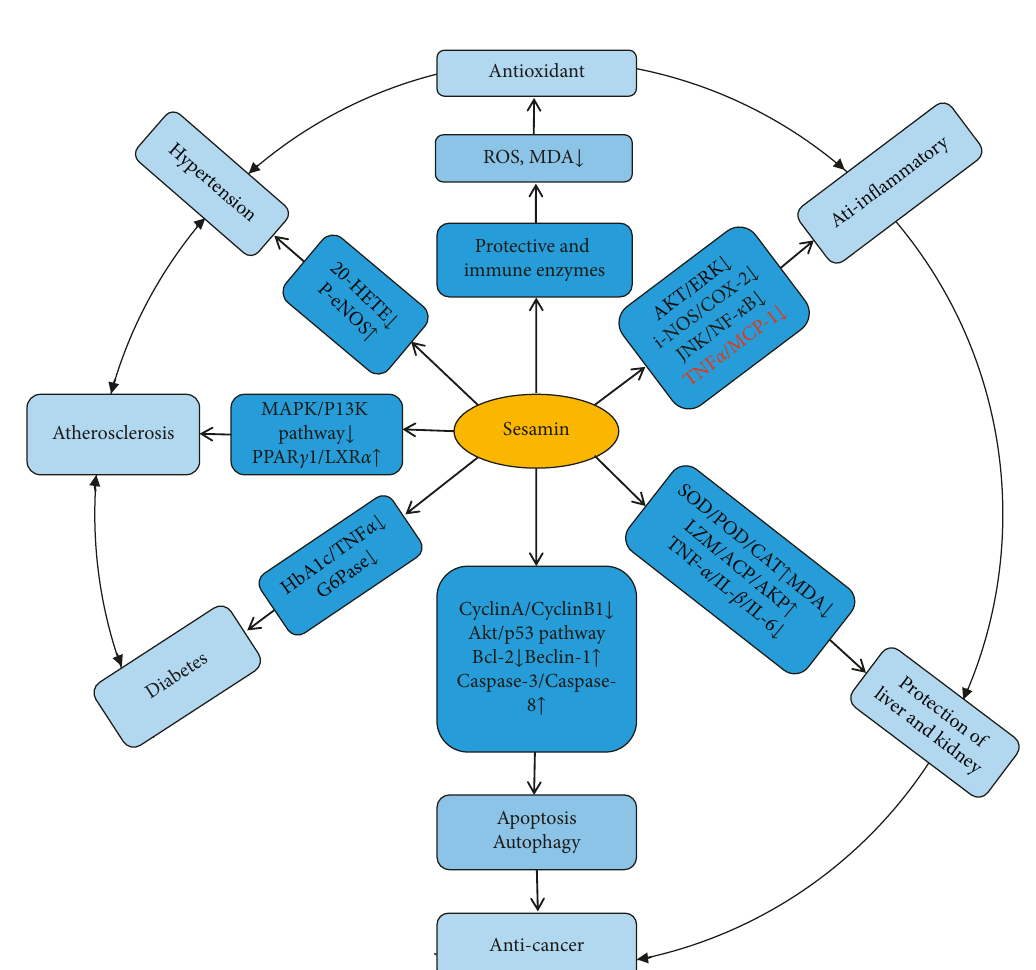
Figure 5: Schema of sesamin’s various pharmacological properties and its mechanism of